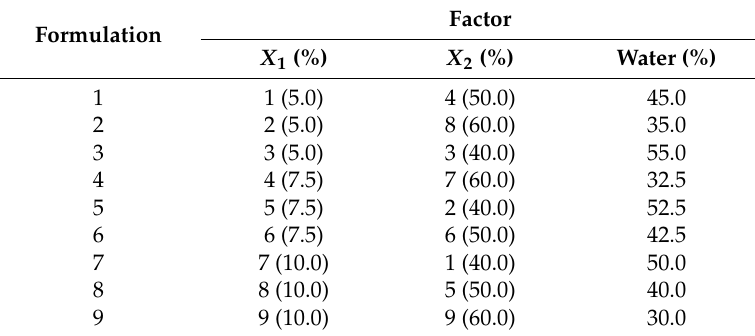
Table 4. Experimental design for optimization of the TMP-MP formulation.